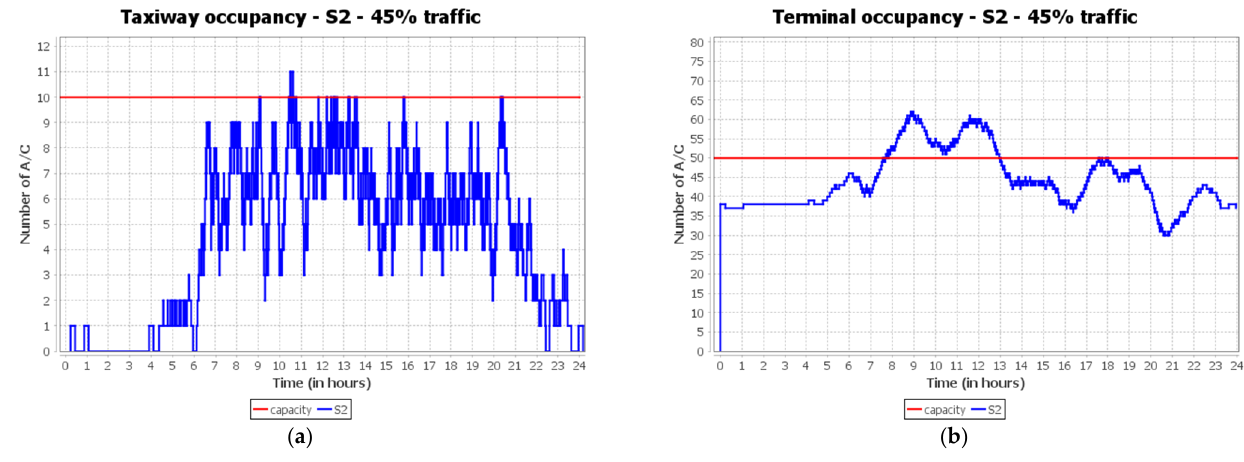
Figure 8. Taxiway ( a ) and terminal ( b ) occupancy scenario S2.